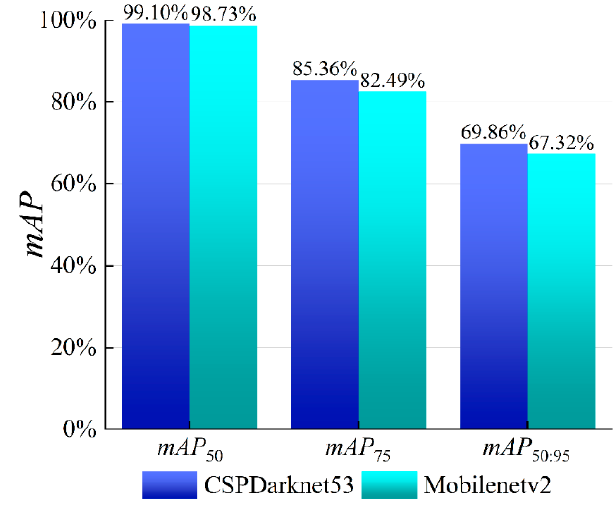
Figure 10. Contrast graphs of the improved backbone network. Table 4. Experimental results under different feature extraction networks.